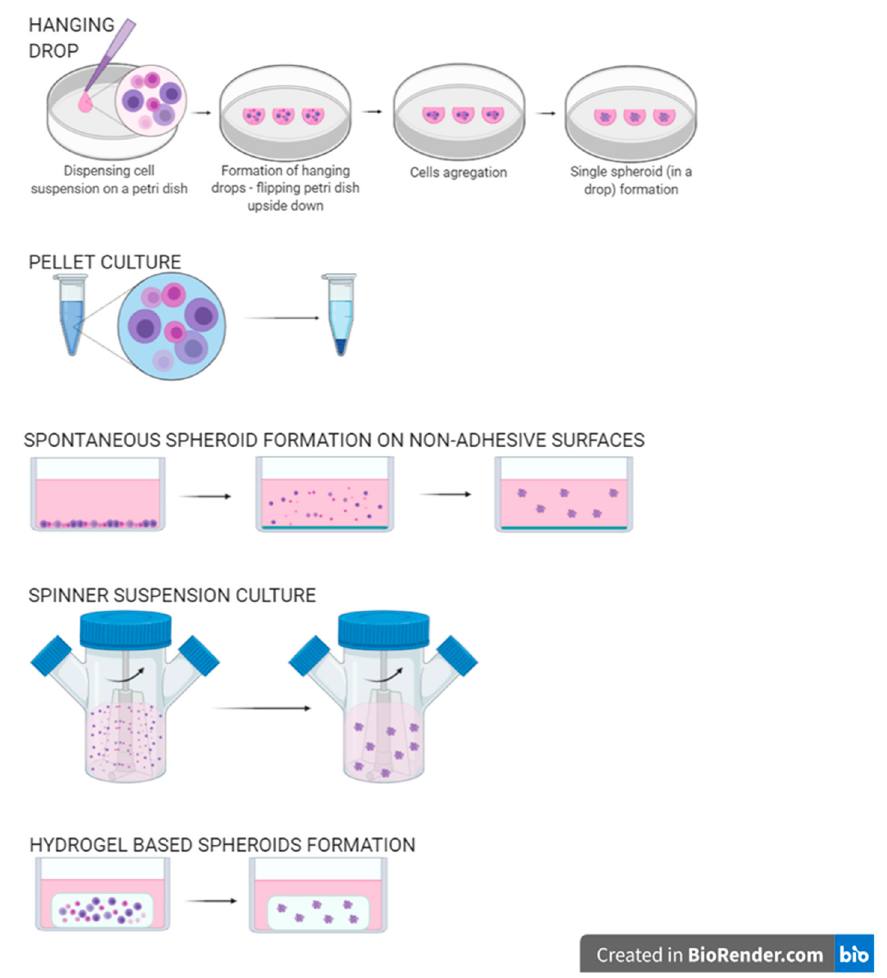
Figure 2. Methods of cell spheroids creation.